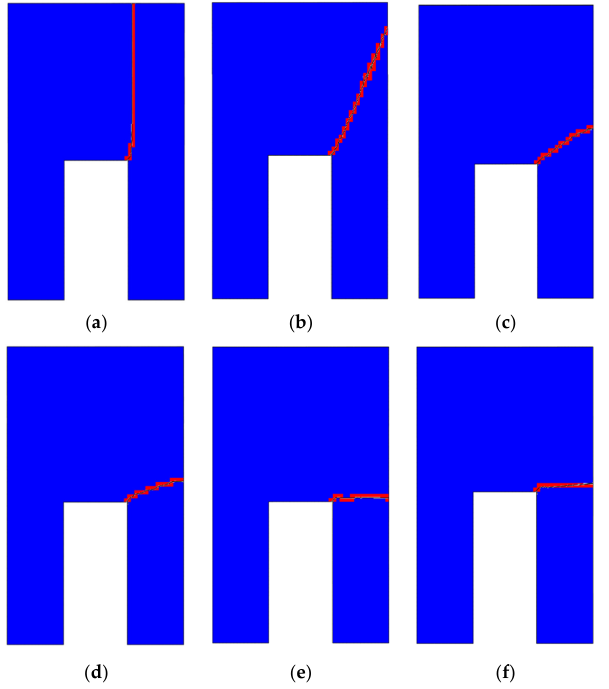
Figure 10. Fracturing extension path simulation results of the samples under different confining pressures. ( a ) 0.2 MPa; ( b ) 0.3 MPa; ( c ) 0.4 MPa; ( d ) 0.5 MPa; ( e ) 0.6 MPa; ( f ) 0.7 MPa.